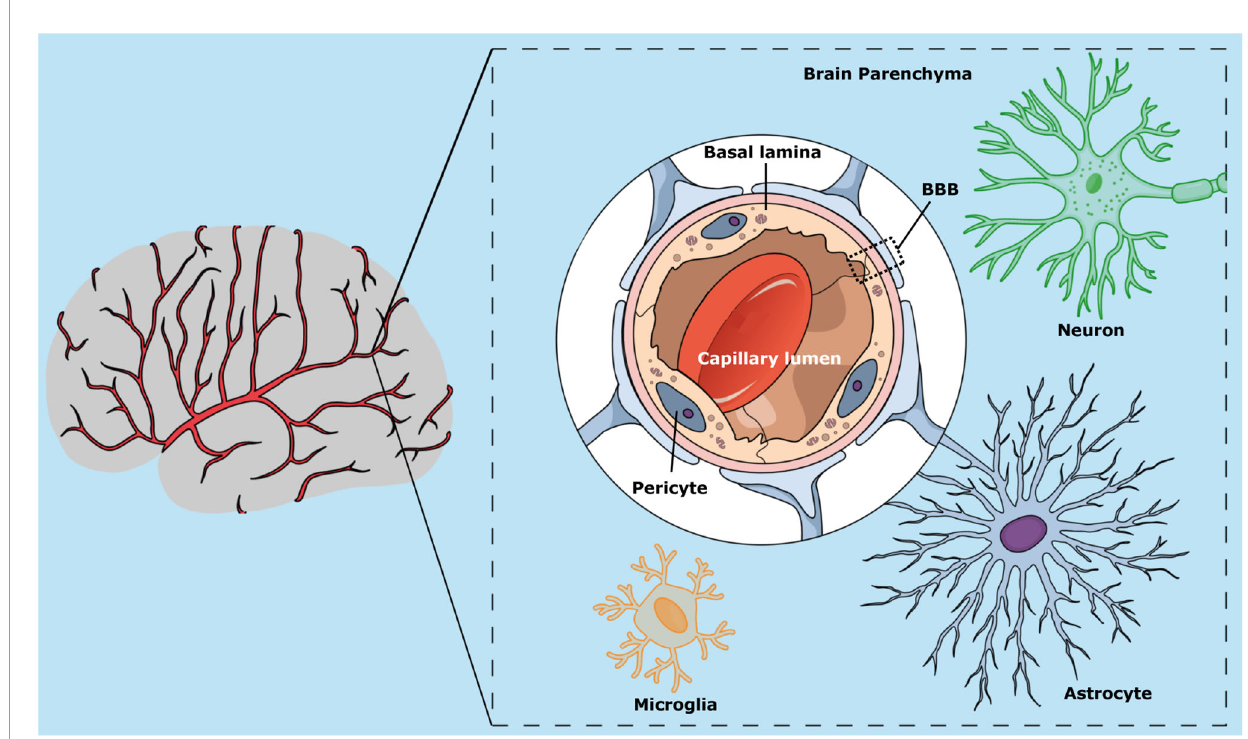
FIGURE 2 | Schematic representation of the blood-brain barrier, showing its main cell components (pericytes, astrocytes, and endothelial cells) and localization in the brain capillary